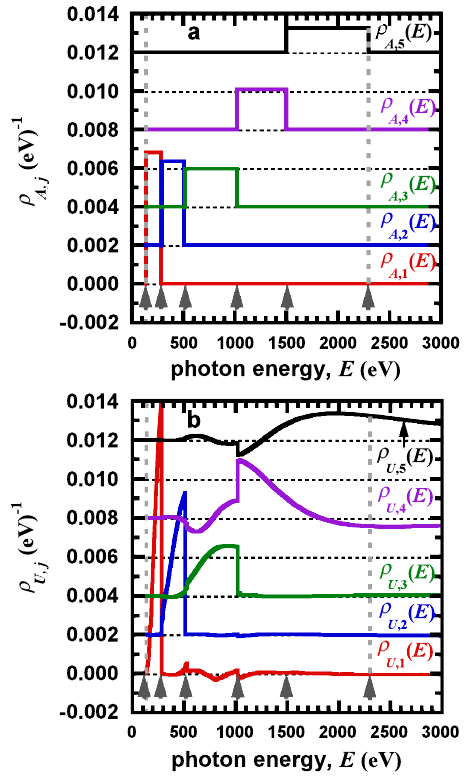
FIG. 3. Binwise passband functions, (cid:14) A;j ð E Þ and (cid:14) U;j ð E Þ , for the averaging operator A and the unfold operator U ¼ M (cid:4) 1 BD M , respectively. In both figures, the baselines are displaced for clarity, dashed vertical lines denote the unfold interval ½ (cid:1) E (cid:5) , and arrowheads indicate the unfold bin boundaries. Part (a) graphs averaging passband functions (cid:14) A;j ð E Þ , each of constant value ð (cid:1) E j Þ (cid:4) 1 within the j th unfold bin, but zero elsewhere (Pt. 1: Table II). Part (b) shows the corresponding unfold passband functions (cid:14) U;j ð E Þ , which exhibit x-ray absorption- edge features in the responses (Pt. 1: Fig. 1) but not the high- energy humps of R 1 , R 2 , R 3 (Pt. 1: Figs. 1 and 2). The (cid:14) U;j ð E Þ ’s can be nonzero, and even negative valued, outside bin ½ (cid:1) E j (cid:5)